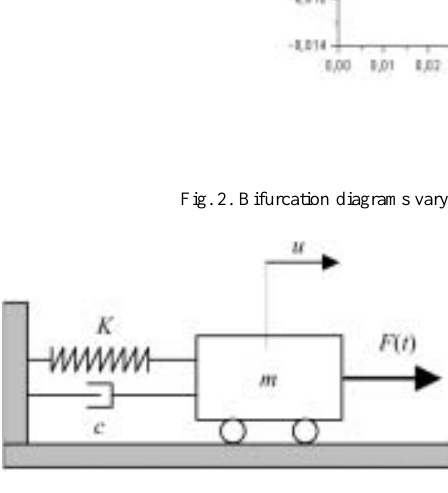
Fig. 1. Shape Memory